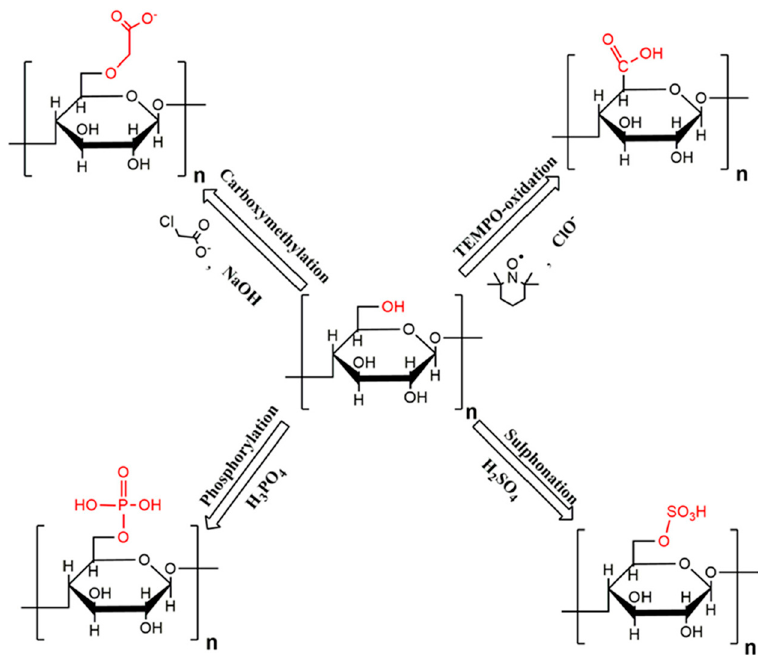
Figure 2. Di ff erent surface modi fi cation techniques through which ionic charges are imparted to the NC surface. Reproduced with permission from [20]. Copyright American Chemical Society,